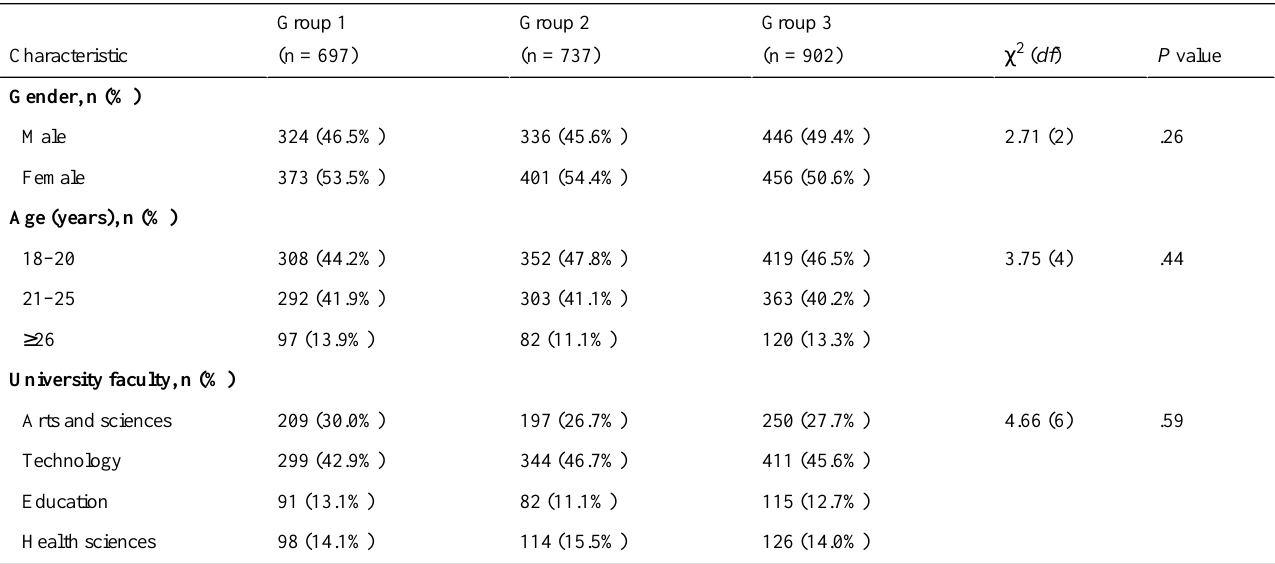
Table 2. Intention-to-treat analyses a of groups 1, 2, and 3 b (total n = 2336): sample